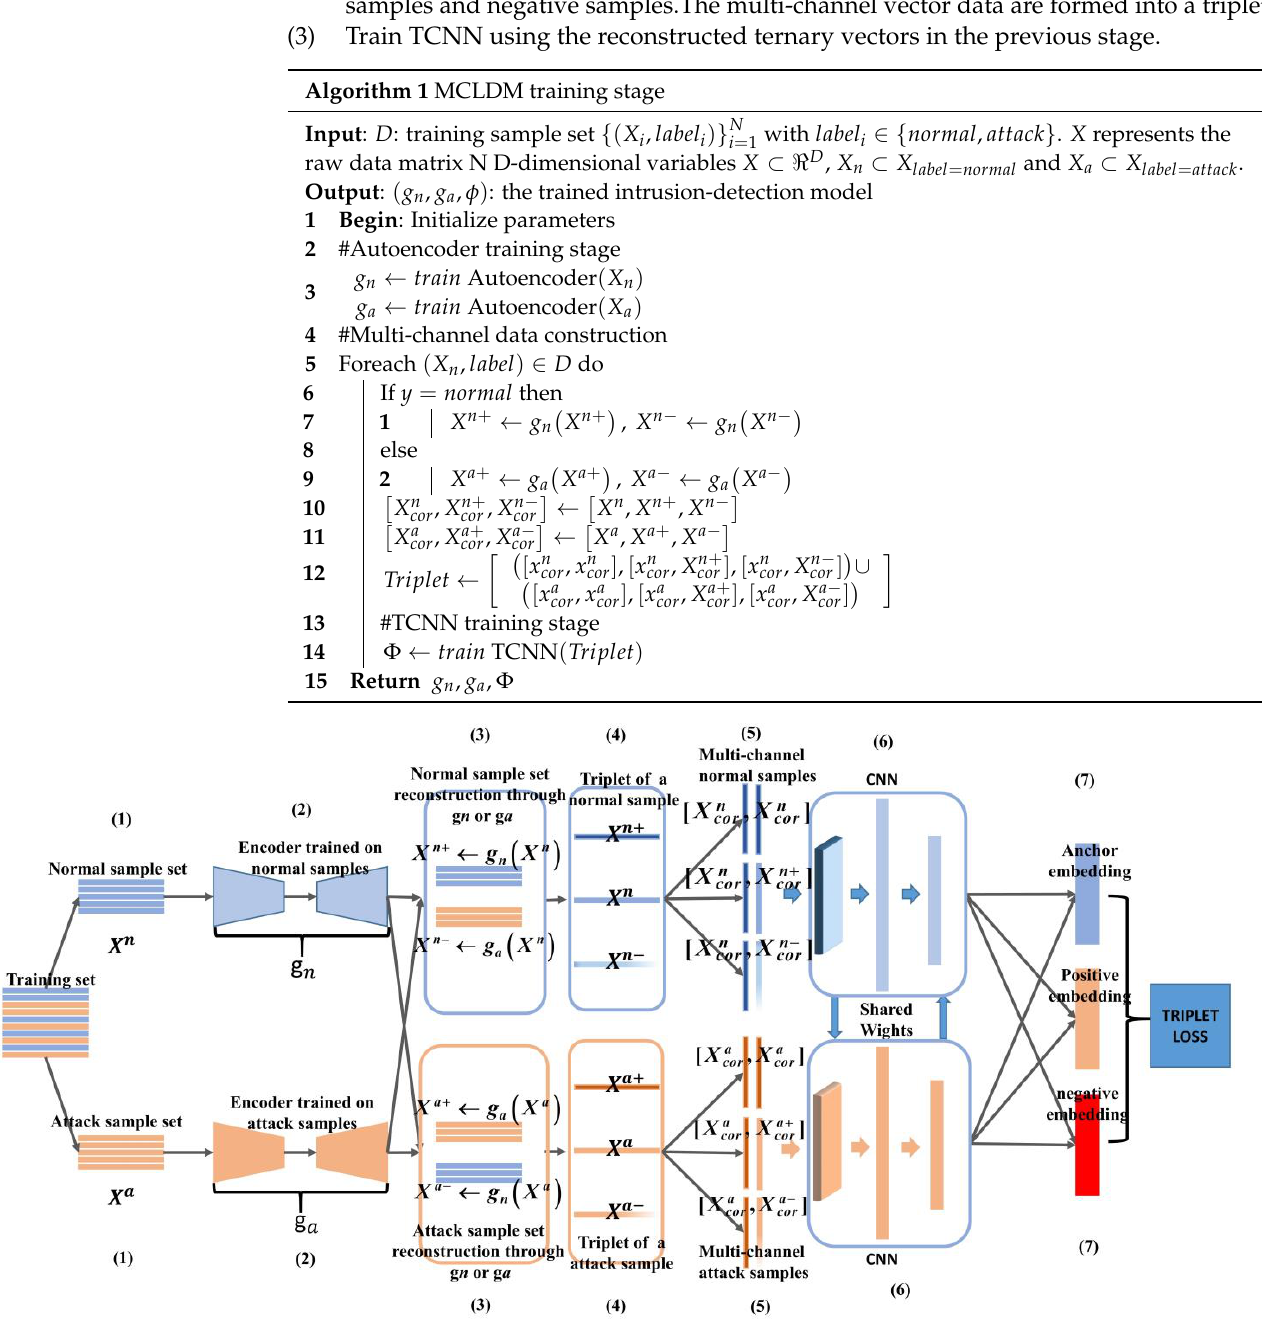
Figure 1. Model training